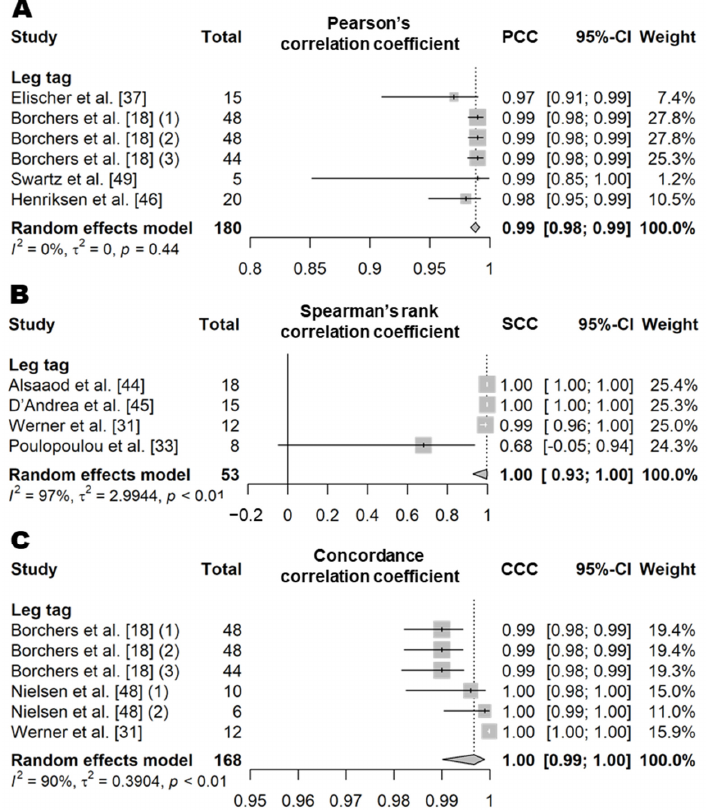
Figure 6. Forest plot of the correlation coefficient of lying time between wearable sensors and visual observation. ( A – C ) show Pearson’s correlation coefficient, Spearman’s correlation coefficient, and concordance correlation coefficient, respectively. Numbers in parentheses indicate individual stud- ies applying different evaluation conditions within the same article. ‘Total’ means the sample size of each study and ‘Weight’ means the weight for the mean based on the sample size.